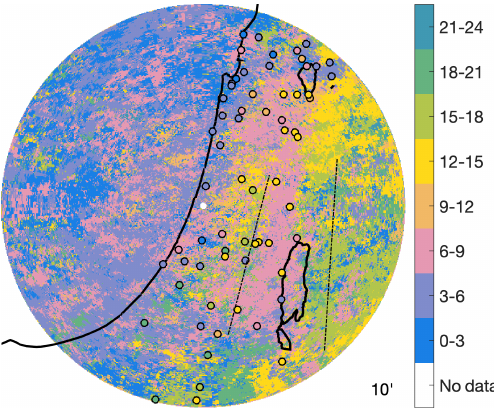
Figure 9. Time of the day at which the highest 45% of the ordi- nary events (i.e., the storm maximal intensities defining the tail of the intensity distribution) at 10min duration are typically observed. Circles colored with the same color scheme show the correspond- ing values obtained from the 10min rain gauges. Dot–dashed lines show the approximate location of the peaks of the two main oro- graphic